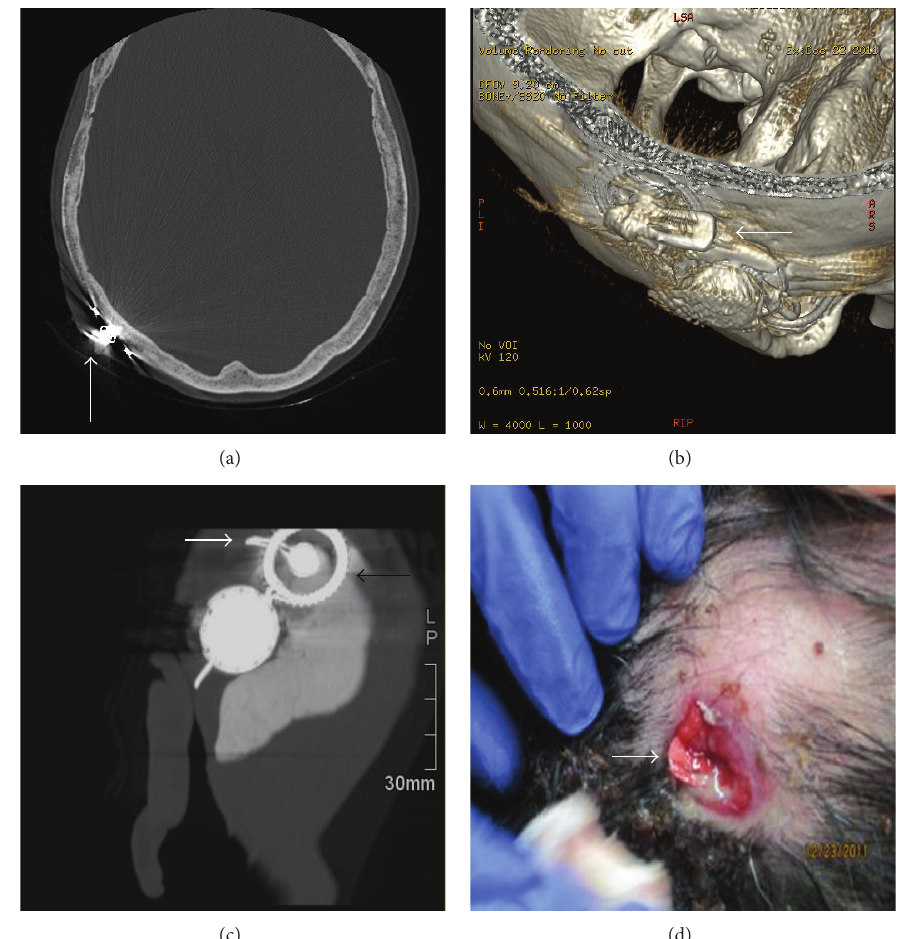
Figure 1: CT images ((a) axial view, (b) multiplanar reconstruction with maximum-intensity projection, and (c) 3D volume rendering) and (d) intraoperative findings of the barrette hair clip (white arrows) and its spatial relationship with the magnet of the receiver stimulator (black